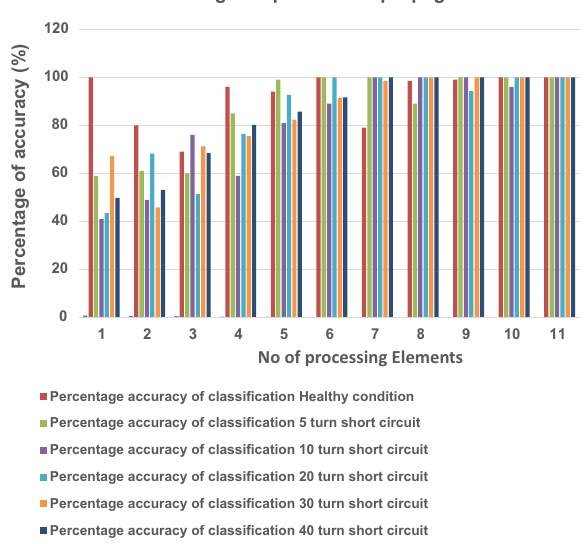
Figure 11. Percentage of accuracy with respect to processing elements in healthy and faulty conditions (cross validation and testing data set).